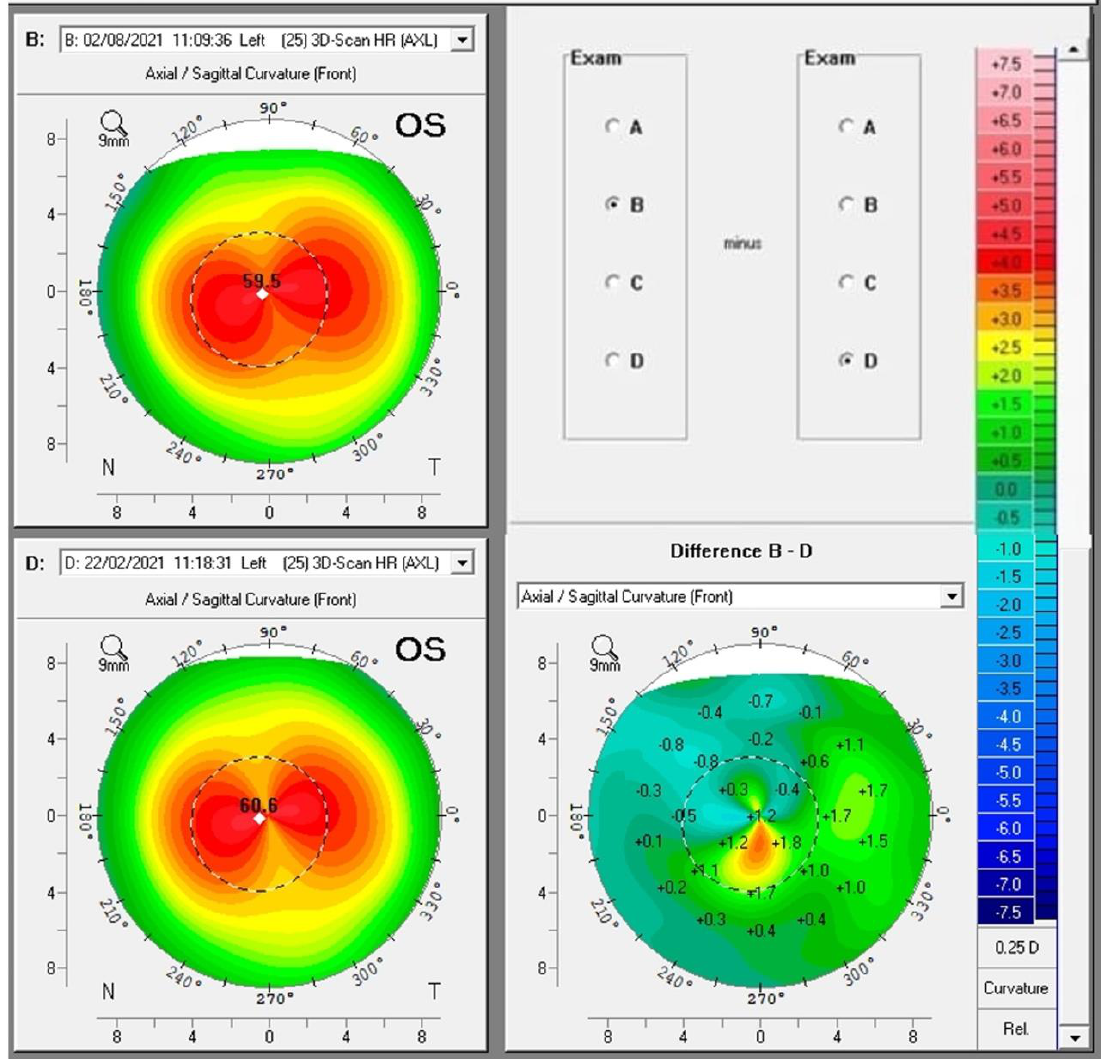
Figure 1. Pentacam differential map showing progression in OS (B-D). Observing only K max, we tended to believe that the KC improved from 60.6 in February 2021 to 59.5 in August 2021, but there was an increase in zonal curvature.